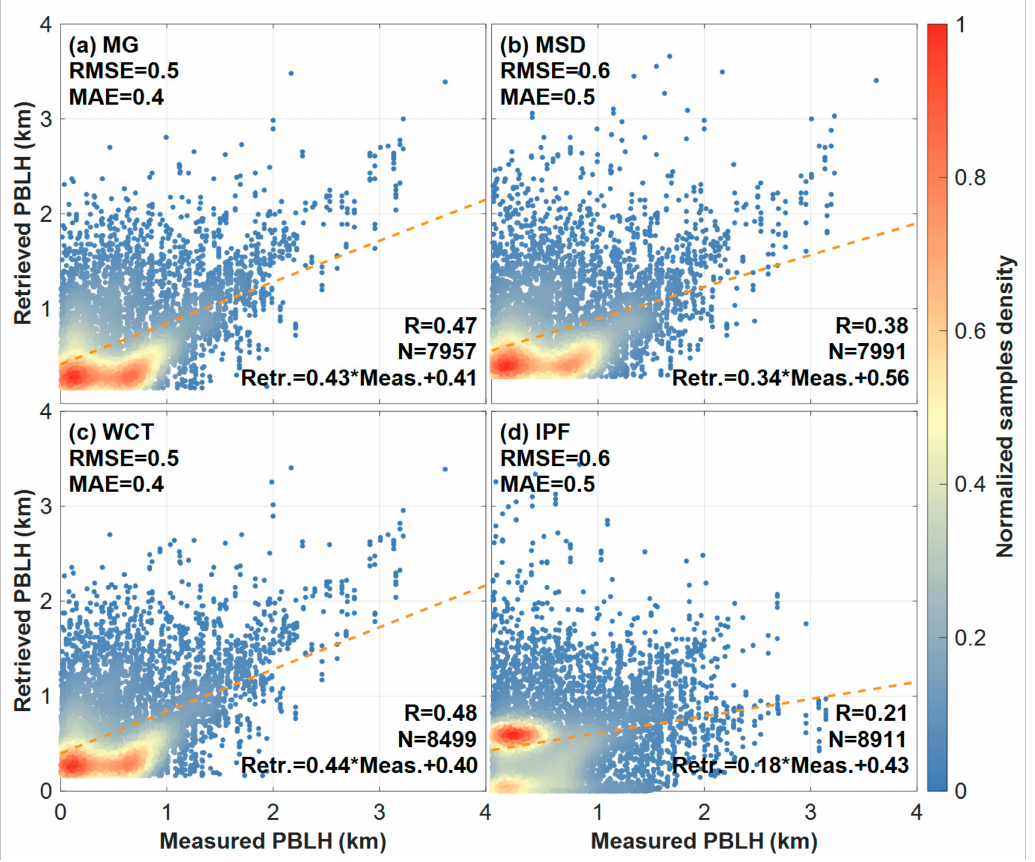
Figure 4. PBLHs derived by ( a ) MG, ( b ) MSD, ( c ) WCT, and ( d ) IPF compared with radiosonde